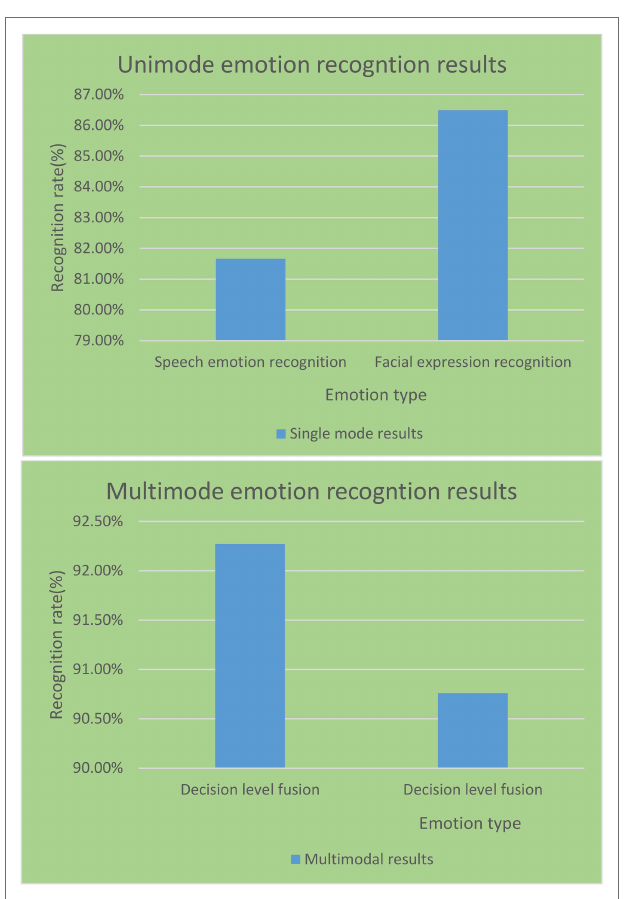
FIGURE 13 | Recognition performance of single-modal and multi-modal recognition techniques.